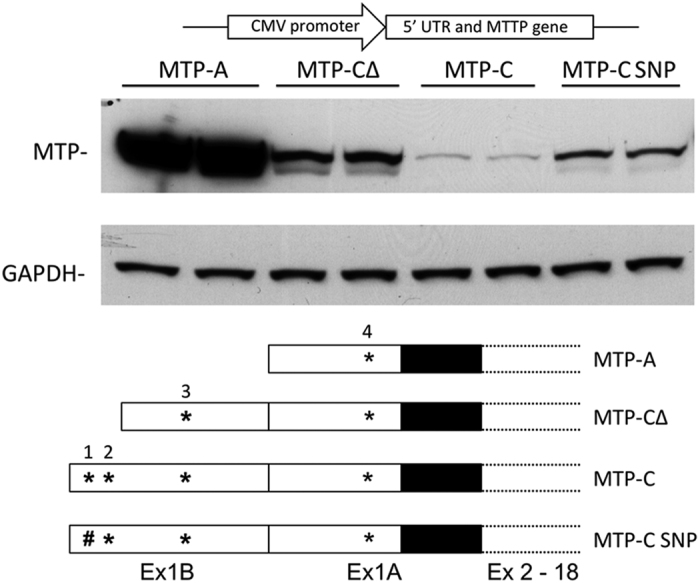
Effect of upstream ATGs on protein expression.HEK293 cells were transfected with human MTP-A, MTP-C, MTP-CΔ (MTP-C minus ATG-1 and -2, Fig. 5), MTP-C (SNP) (ATG-1, Fig. 5, mutated to ATA), and cellular protein harvested 72 hours later. A schematic of the vectors used is shown at the top. MTP protein was detected by immunoblot and quantitated by densitometry using GAPDH as load control. *uATG; #SNP rs11944752, ATG > ATA.